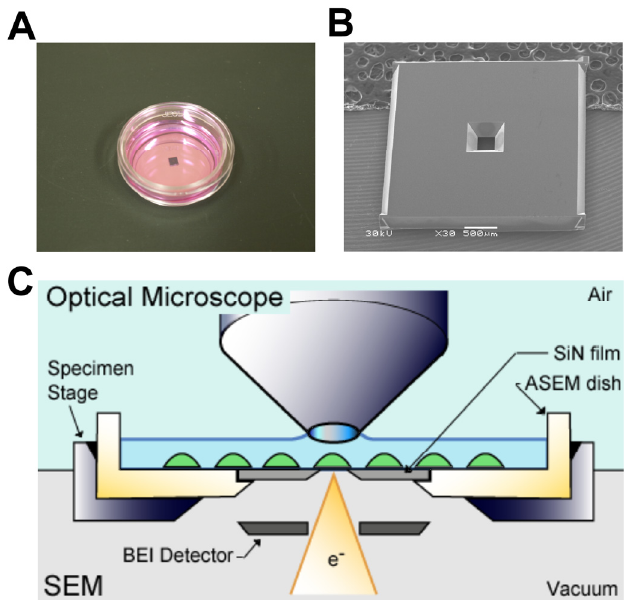
Figure 1. Correlative light and electron microscopy (CLEM) by atmospheric scanning electron microscope (ASEM). ( A ) ASEM dish. A removable 35-mm ASEM dish has a 100-nm silicon nitride (SiN) film window separating vacuum and atmosphere; ( B ) SEM image of an SiN window. Scale bar, 500 µm; and ( C ) Schematic diagram of the ASEM system. An optical microscope capable of fluorescence imaging, is arranged above the inverted SEM, with the specimen dish between them. The removable 35-mm ASEM dish features an SiN film window in its bottom plate, which separates vacuum and atmosphere. The electron beam is projected from underneath onto the cells through the SiN film, and backscattered electrons are captured by the backscattered electron imaging (BEI) detector. The axes of both microscopes are mechanically aligned, and the specimen stage can be shifted two-dimensionally on the X – Y